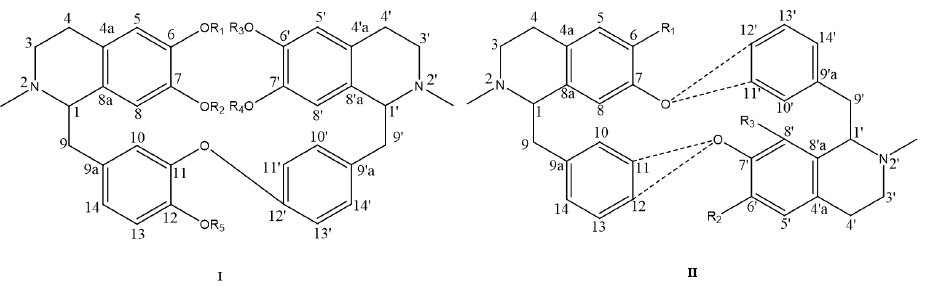
Figure 1. Structural skeletons of bisbenzylisoquinoline alkaloids in M. Rhizoma.